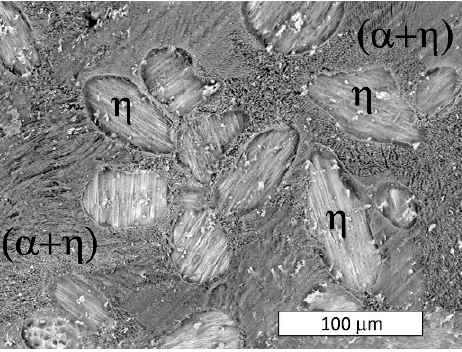
Figure 13. The surface of a sample after polarization up to a potential of +450 mV vs. E corr . Changes on the sample surface due to corrosion are visible over the entire alloy surface. SEM.